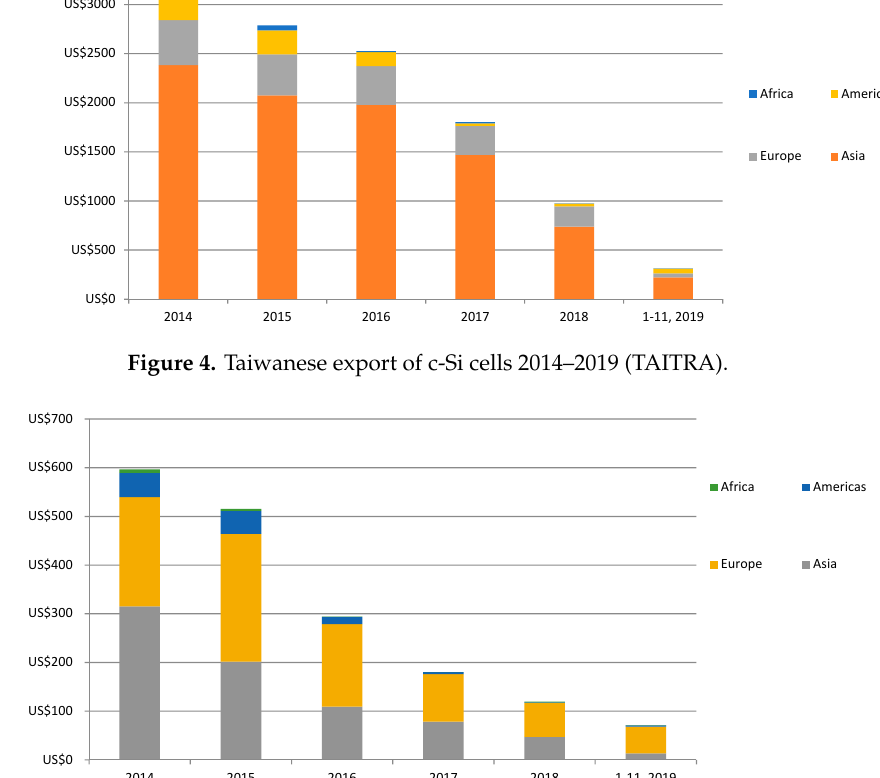
Figure 5. Taiwanese export of c-Si modules 2014–2019 (TAITRA).